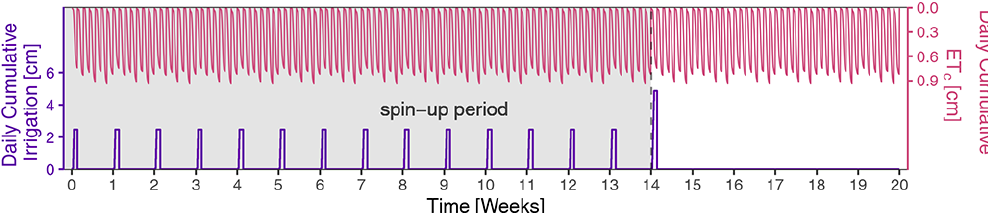
Figure 3. Daily cumulative irrigation and potential crop evapotranspiration through the 14 weeks of spin-up period (gray background) and the final simulation.